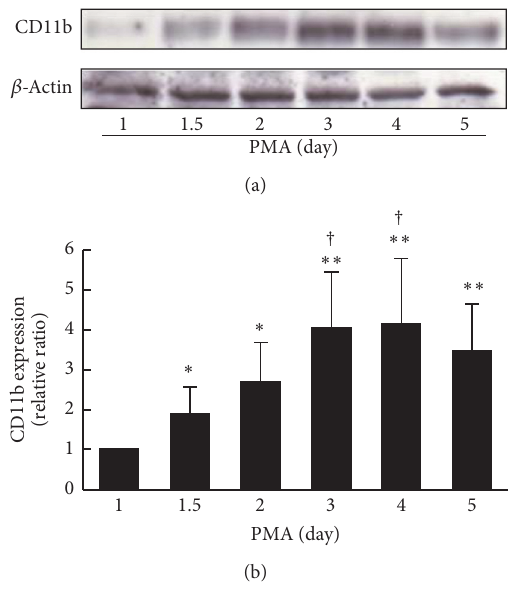
Figure 2: CD11b expression on THP-1 cells treated with PMA for different periods. (a) After PMA treatment for 1 to 5 days, cell lysates (10 𝜇 g of proteins) were separated by SDS-PAGE (7% polyacrylamide gel) and detected with anti-CD11b or anti- 𝛽 -actin antibodies. (b) The expression of CD11b also shows bar graphs. The value at day 1 was defined as 1. The values were indicated by mean + SD ( 𝑛 = 4, ∗ 𝑃 < 0.05 versus day 1, ∗∗ 𝑃 < 0.01 versus day 1, and † 𝑃 < 0.05 versus day 1.5).